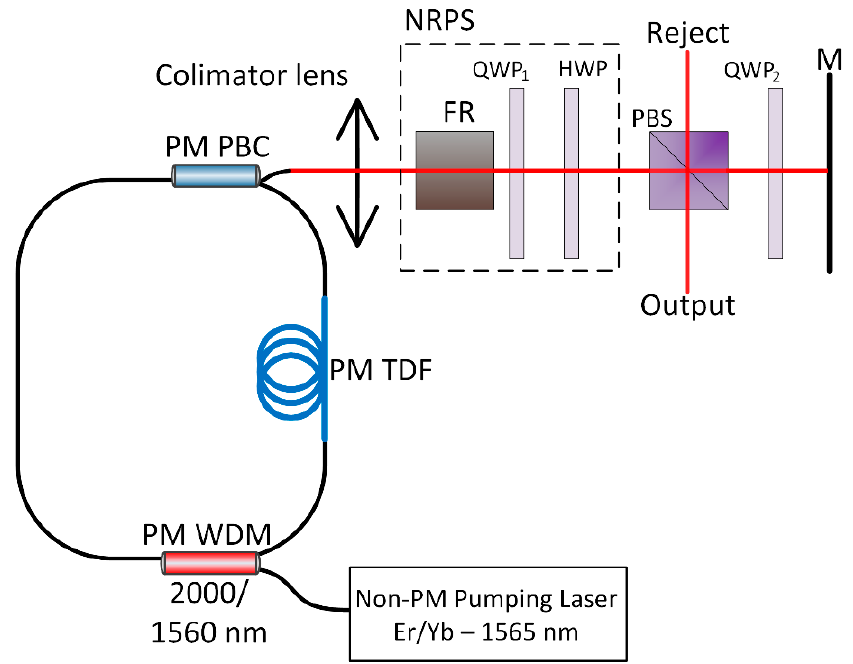
Figure 1. Experimental setup of all-PM NALM-based Tm-doped fiber laser. WDM: wavelength division multiplexer; PBC/PBS: polarization beam combiner/splitter; TDF: Thulium-doped fiber; FR: Faraday rotator; QWP: quarter-wave plate; HWP: half-wave plate; M: mirror, NRPS: non-reciprocal phase shifter.